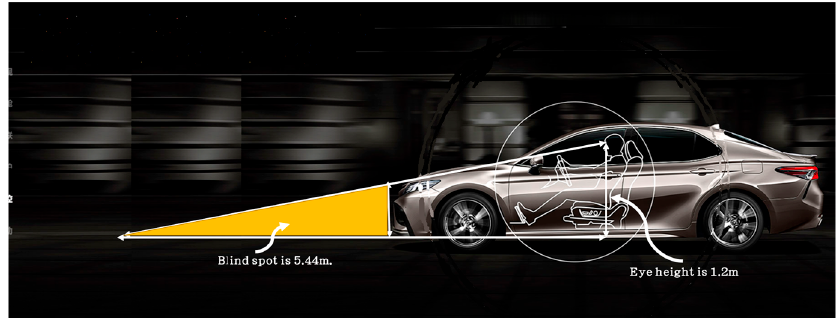
Figure 1. Front blind area of vision when a car is driving on a flat road. The slope of the ground significantly influences the front blind area of the vehicle. When the car is going uphill, the front blind area becomes more extensive; when the vehicle is going downhill, the front blind area becomes smaller, as is shown in Figure 2.